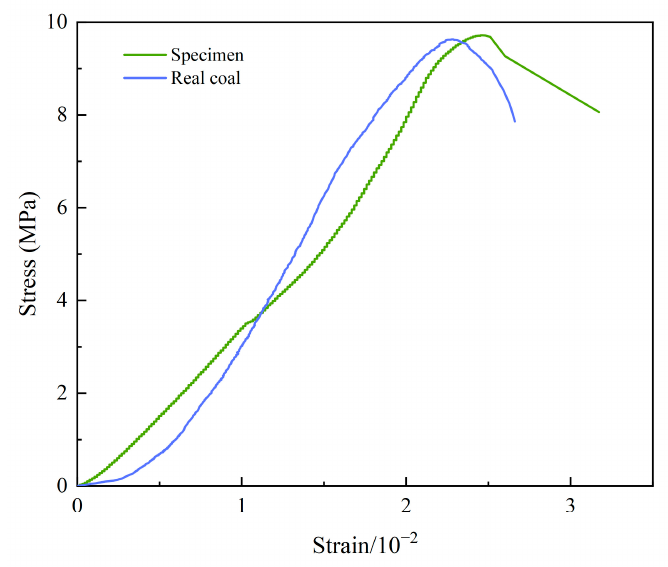
Figure 1. Uniaxial compressive stress–strain curve of real coal and specimen.